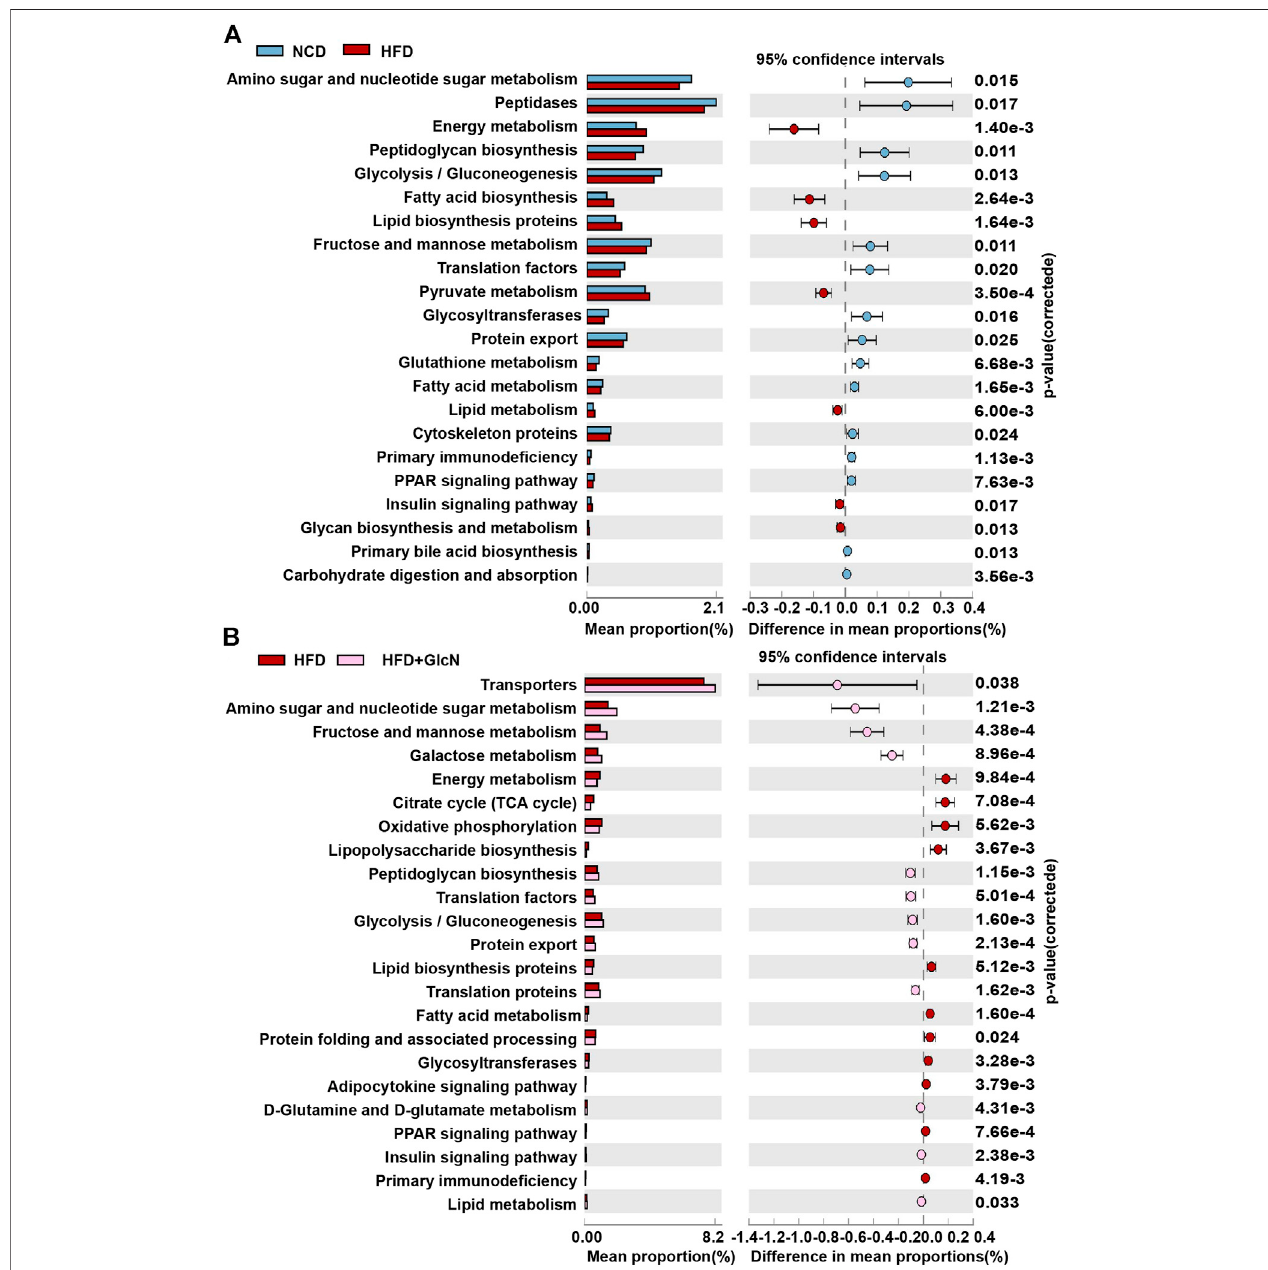
FIGURE 6 | Metabolic function changes of gut microbiota among experimental groups. After the treatment with NCD, HFD, and/or GlcN (1 mg/ml, in drinking water) for 5 months, all mice were sacri fi ced and the cecal contents were collected for 16S rDNA sequencing. By using PICRUSt analysis, the metabolic alteration of KEGG pathways in the HFD group (A) and the reversal effect of GlcN treatment (B) were analyzed.